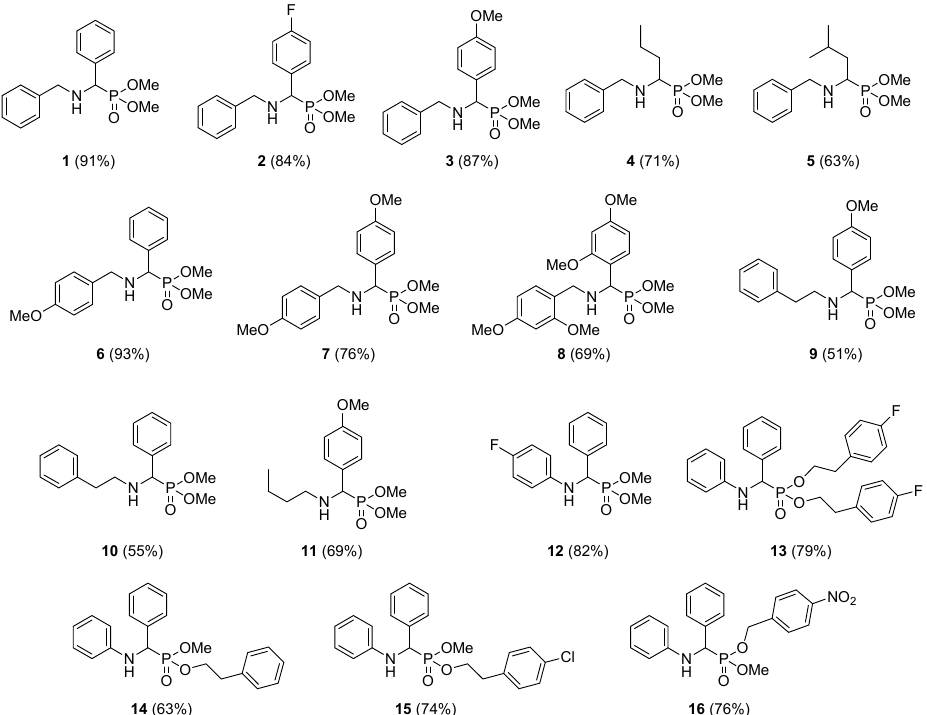
Figure 2. α -Aminophosphonates 1 – 16 obtained via an enzyme-catalyzed Kabachnik–Fields reaction. Yields in brackets provided for isolated products 1 – 16 .